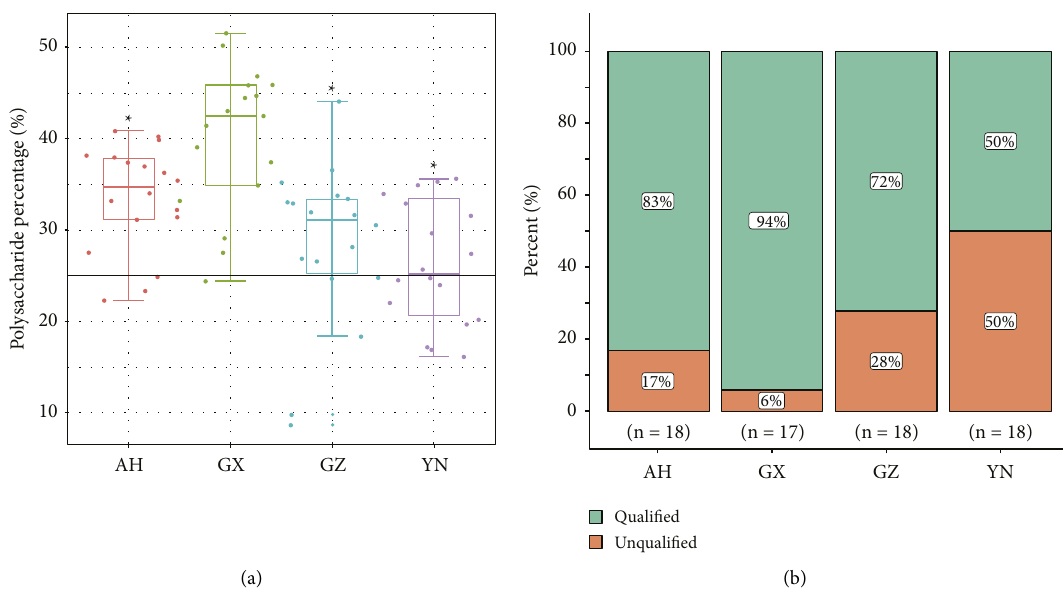
Figure 1: Te polysaccharide content assessment of D. ofcinale from four regions. (a) Polysaccharide content of D. ofcinale from four regions. ∗ indicates signifcant diference compared to GX ( p < 0 . 05). (b) Polysaccharide qualifcation rate of D. ofcinale from four regions.